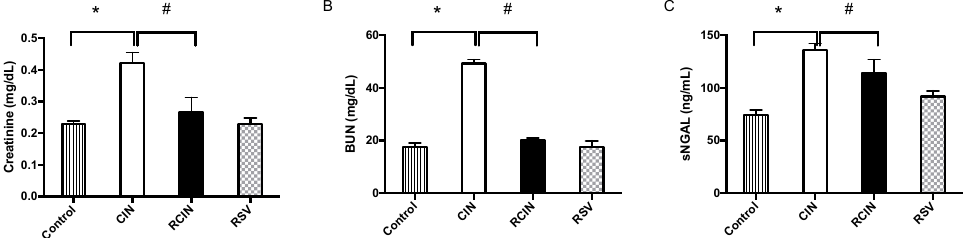
Figure 1. Resveratrol attenuated renal injury after exposure to contrast medium. Blood of the control, contrast-induced nephropathy (CIN), resveratrol + contrast media (RCIN), and resveratrol (RSV) groups of rats were collected 24 h after exposure to contrast medium. Serum ( A ) creatinine, ( B ) BUN, ( C ) Serum neutrophil gelatinase-associated lipocalin (NGAL). Data are presented as mean ± standard error ( n = 8 per group). *: p < 0.05 versus control; #: p < 0.05 versus RCIN. RSV = resveratrol; CIN = contrast-induced nephropathy; RCIN = resveratrol before contrast-induced nephropathy. Group comparisons were evaluated by ANOVA followed by Tukey’s test.